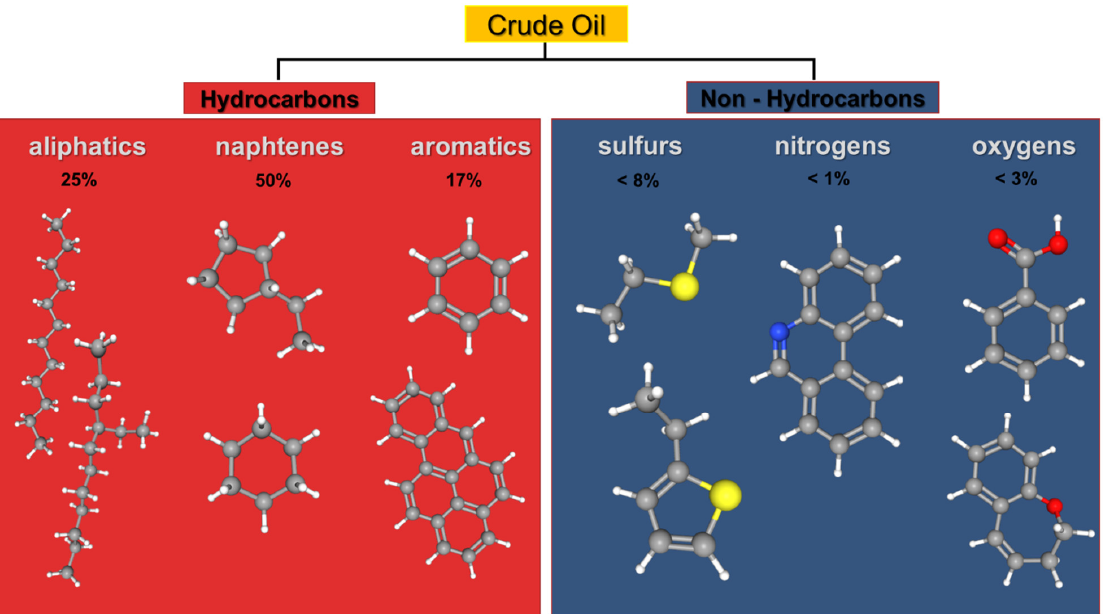
Figure 3. Schematic representation of organic compounds in crude oil. Atoms are reported in grey (C), white (H), yellow (S), blue (N) and red (O).